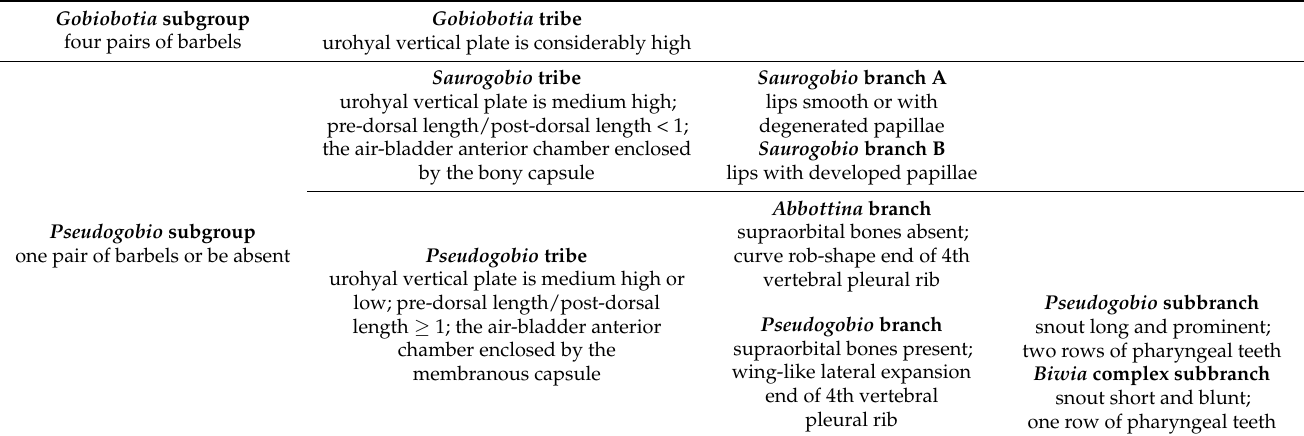
Table 2. The morphological or osteological characters for classification of the Pseudogobionini group. Gobiobotia subgroup four pairs of barbels